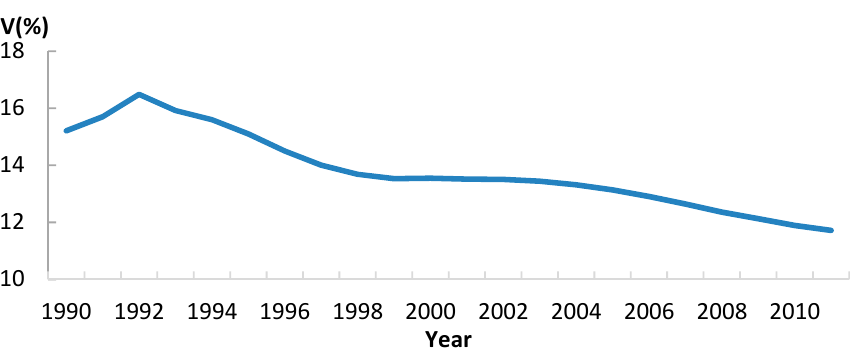
Figure 8. The trend of Coefficient of Variation for LE in Africa, 1990–2011.